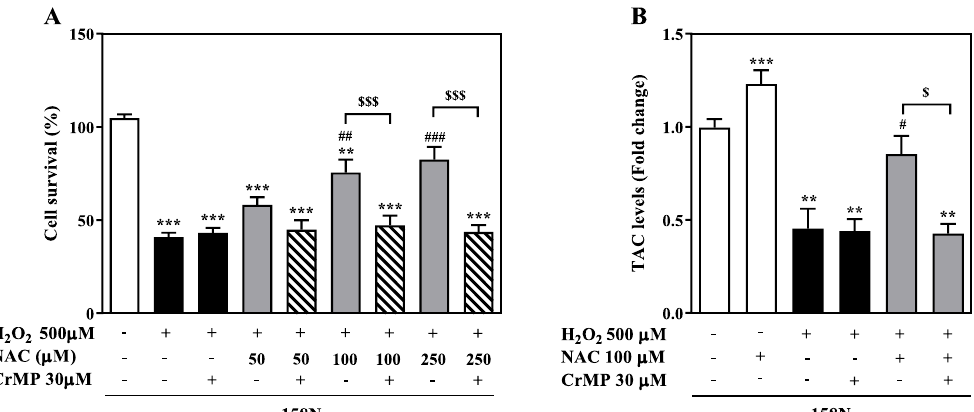
Figure 4. HO-1 activity plays a vital role in the cytoprotective action of NAC. ( A ) 158N cells were incubated with H 2 O 2 (500 µ M) for 24 h with or without NAC (50 to 500 µ M) and CrMP (30 µ M), a HO activity inhibitor. ( B ) 158N cells were treated for 24 h using different combinations of H 2 O 2 (500 μ M), NAC (100 μ M) and CrMP (30 μ M). Cell survival ( A ) and total antioxidant capacity (TAC) levels ( B ) were quantified using commercial kits. Cell survival was calculated as the percentage of control cells and the results were expressed as mean ± SEM. TAC levels are represented as relative fold change. The data were analyzed by one-way ANOVA with Tukey’s post-hoc test. *** p < 0.001 and ** p < 0.01 show significance between control and treated groups. ### p < 0.001, ## p < 0.01 and # p < 0.05 show significance between H 2 O 2 alone compared to treated groups. $$$ p < 0.001 and $ p < 0.05 indicate significance between H 2 O 2 and NAC groups in the presence or absence of CrMP.